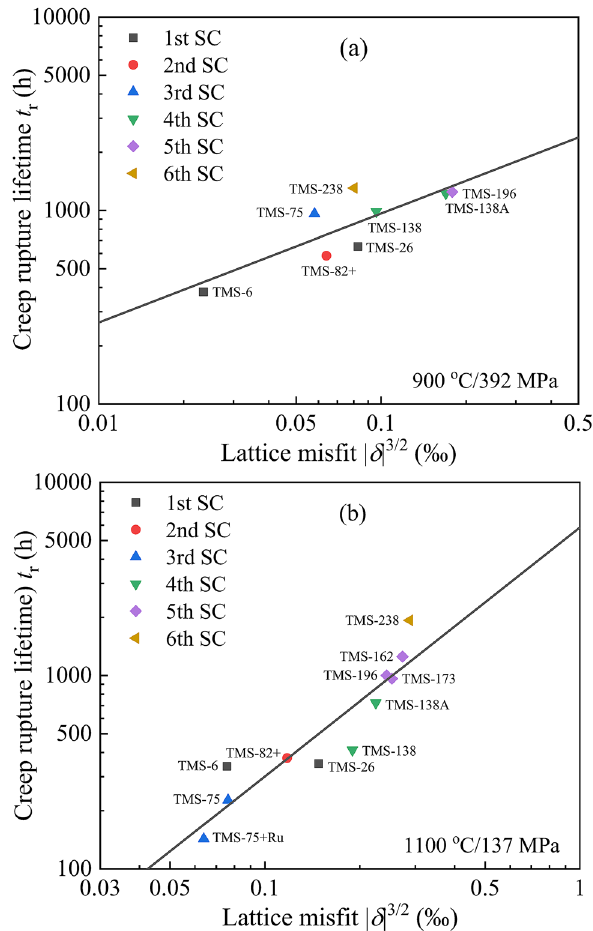
Figure 3. Relationship between the lattice misfit δ and creep rupture lifetime t r of typical TMS series of SC superalloys with prominent creep properties at 900 °C/392 MPa ( a ) and 1100 °C/137 MPa ( b ),